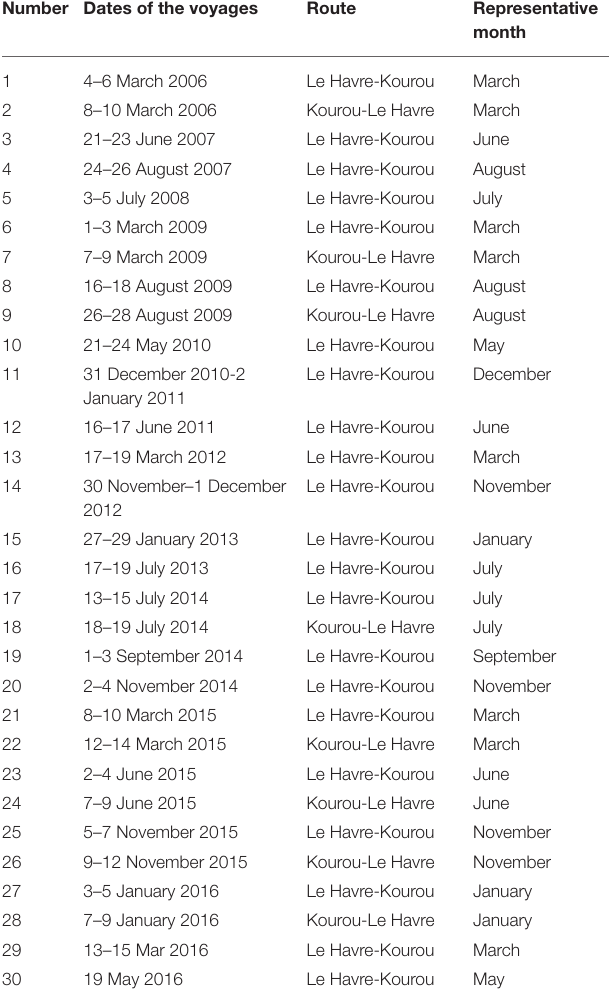
TABLE 1 | Voyages of the MN Colibri with fCO 2 measured on the continental shelf of French Guiana. Number Dates of the voyages